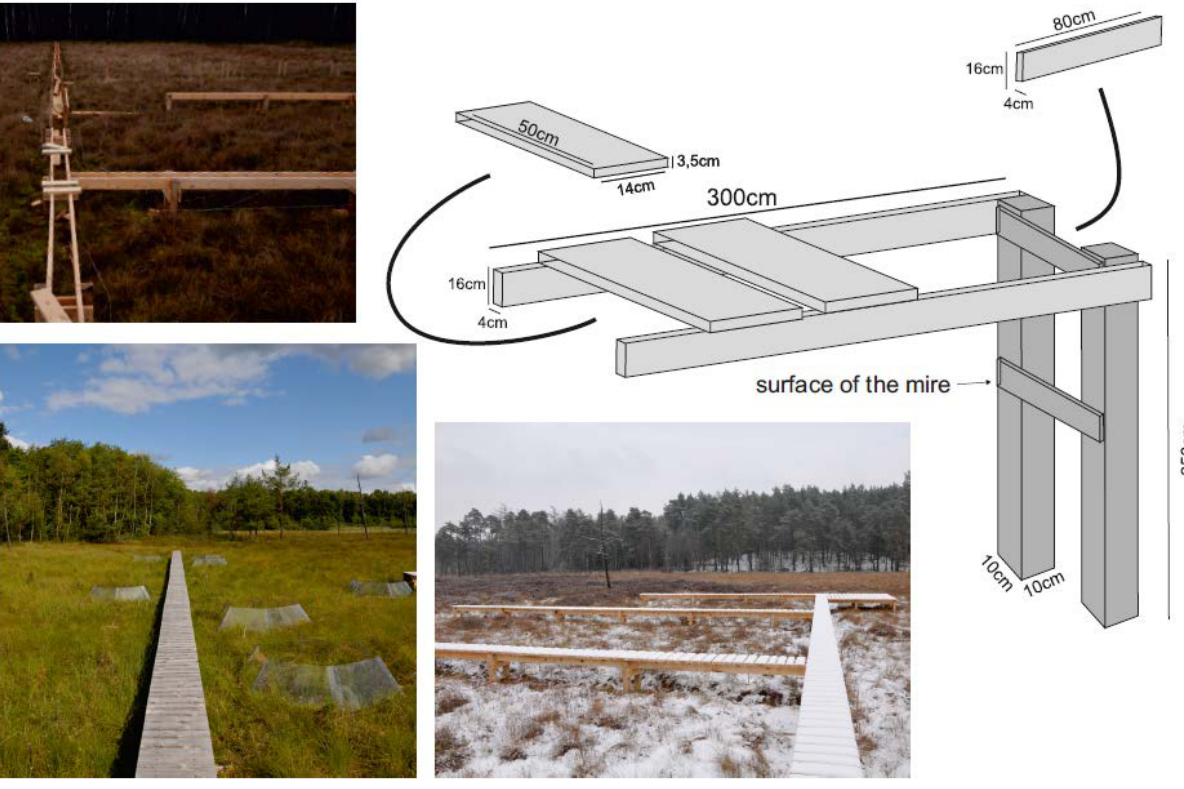
Figure 7. Design of the boardwalk at Linje